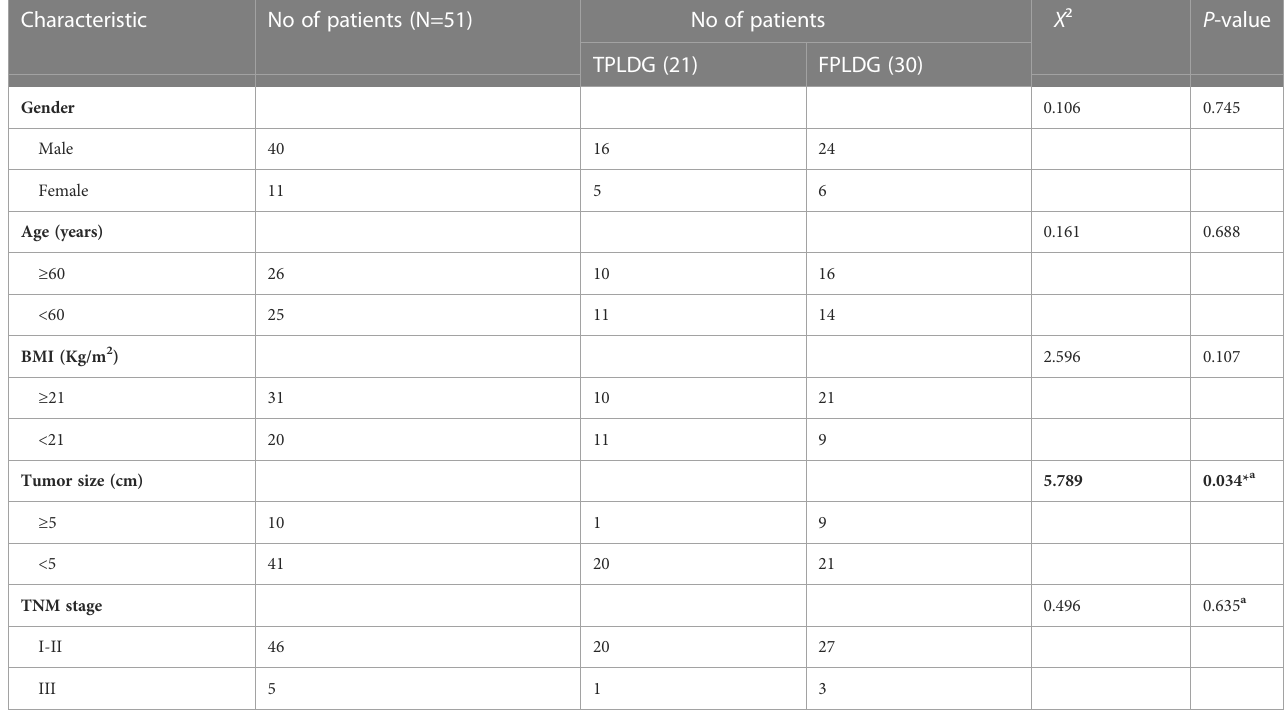
TABLE 1 Patient demographics and baseline clinicopathological characteristics.